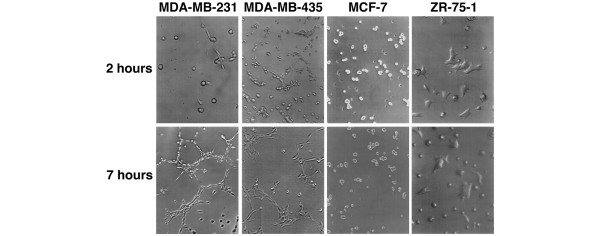
Kinetics of vascular channel formation by breast cancer cells. MDA-MB-231, MDA-MB-435, MCF-7, and ZR-75-1 cells were serum starved overnight, plated on matrigel, and images using phase contrast microscopy were taken at the times indicated. The MDA-MB-231 and MDA-MB-435 cells started to form vascular channels as early as 2 hours after plating on matrigel. Well defined patterned networks were observed by 7 hours. MCF-7 and ZR-75-1 cells failed to form patterned networks.